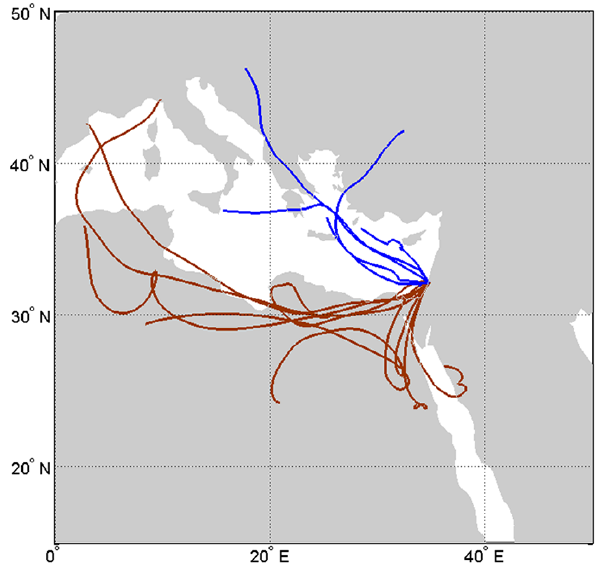
Figure 6. Back-trajectory history of air masses showing passage of air prior to reaching the sampling station. Each line represents a 72h trajectory at 500m altitude. The back trajectories were taken from http://www.arl.noaa.gov. The brown lines represent dust storm conditions and the blue lines represent clean